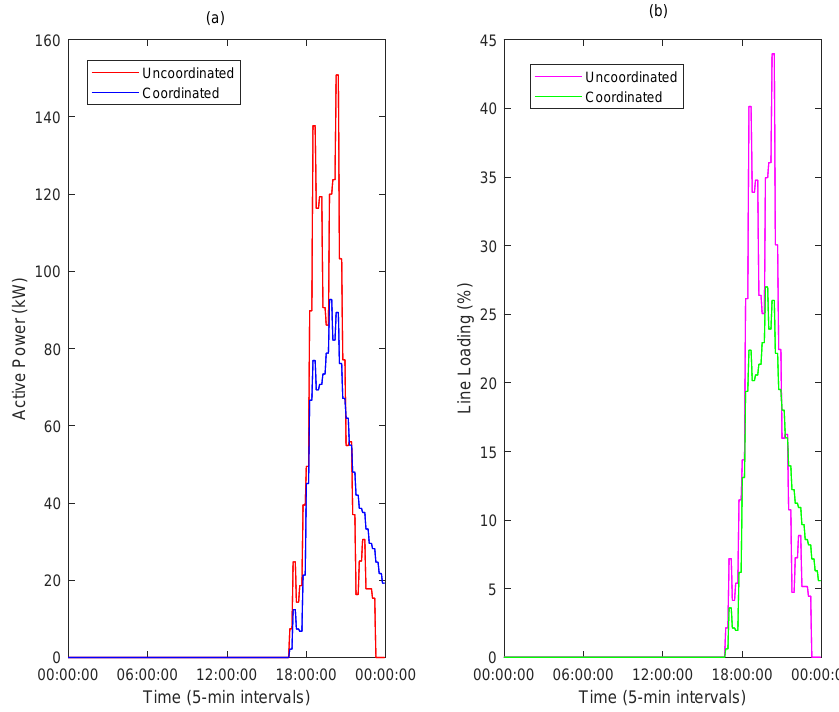
Figure 9. Total EV power ( a ), and distribution line loading ( b ) for uncoordinated charging vs. proposed DCC methods without PV and BES